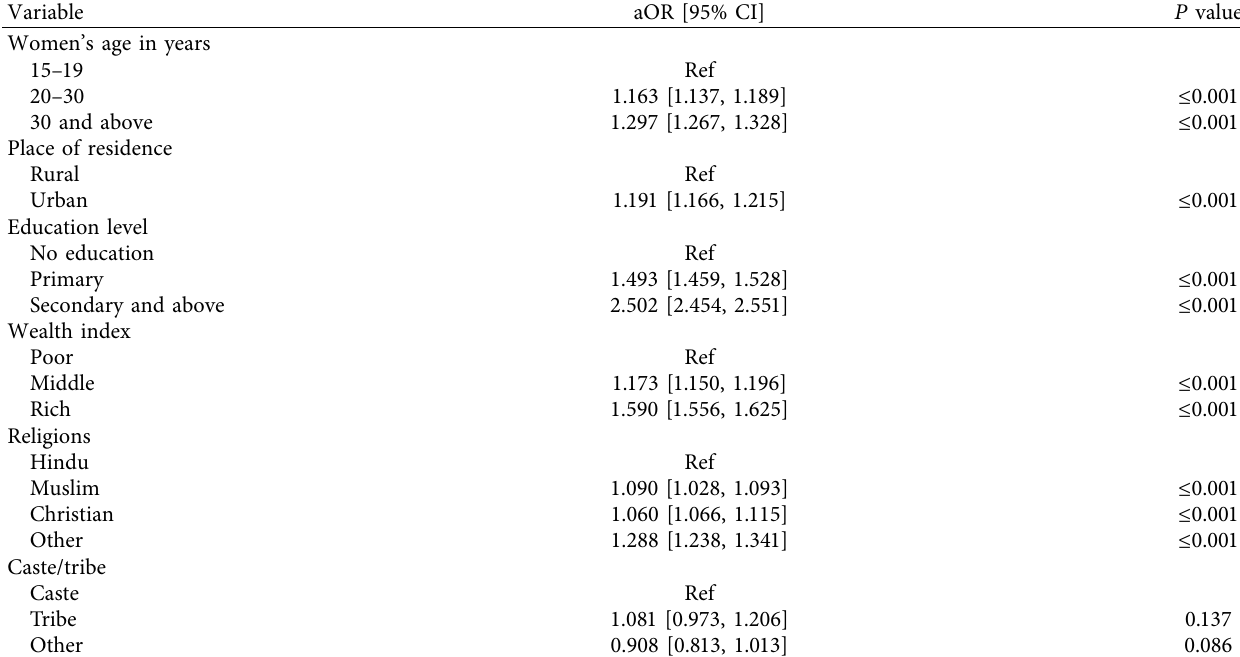
P values by Chi 2 test for categorical variables. Table 4: Multiple logistic regression analysis for association between sociodemographic determinants of knowledge of TB among women in India [ N �